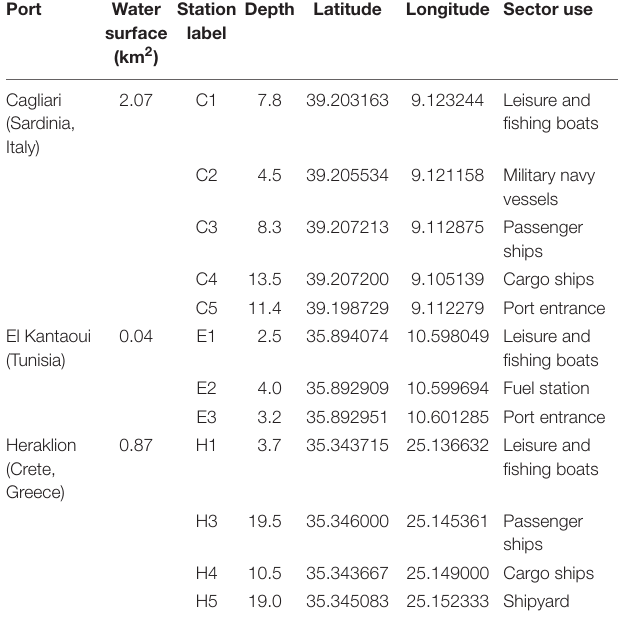
TABLE 1 | Mediterranean touristic ports selected as the study sites (MAPMED Consortium,